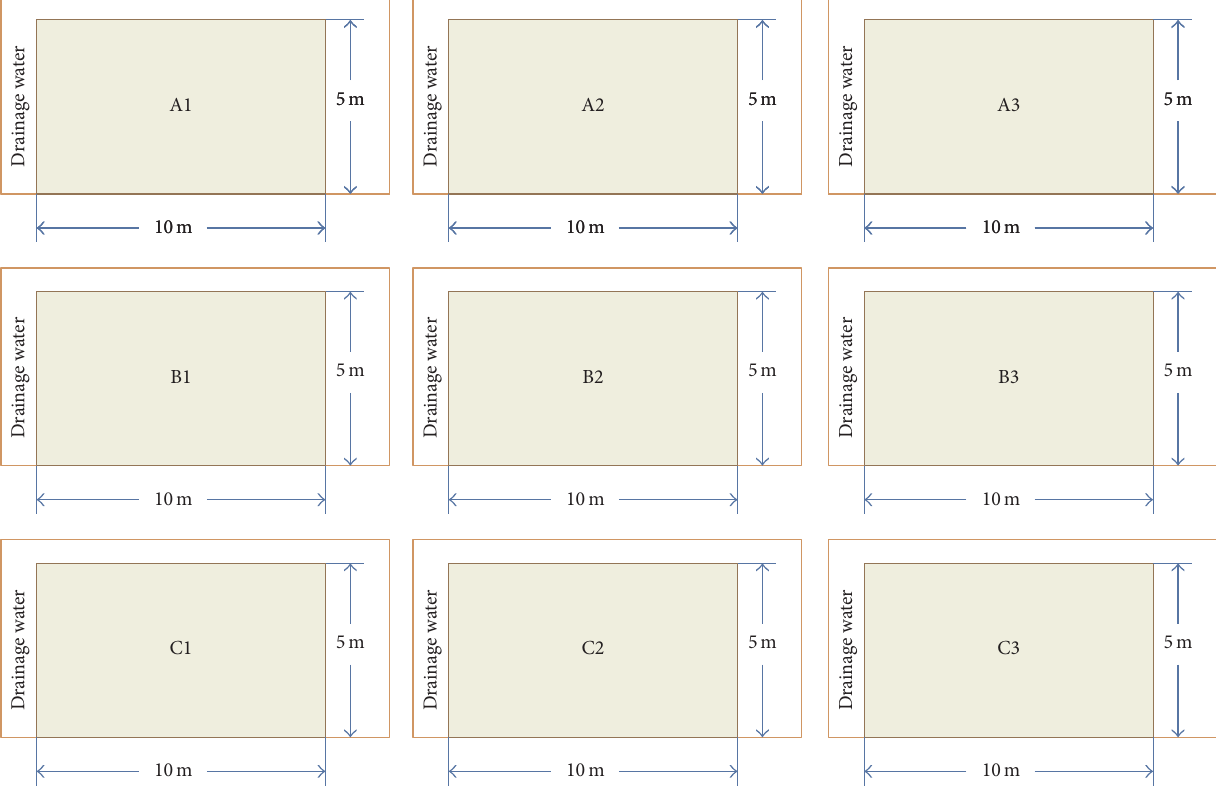
determined by atomic absorption spectrophotometry